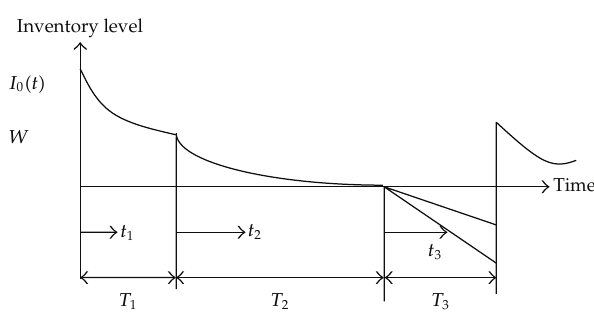
Figure 1: Graphical representation of the OW inventory system.